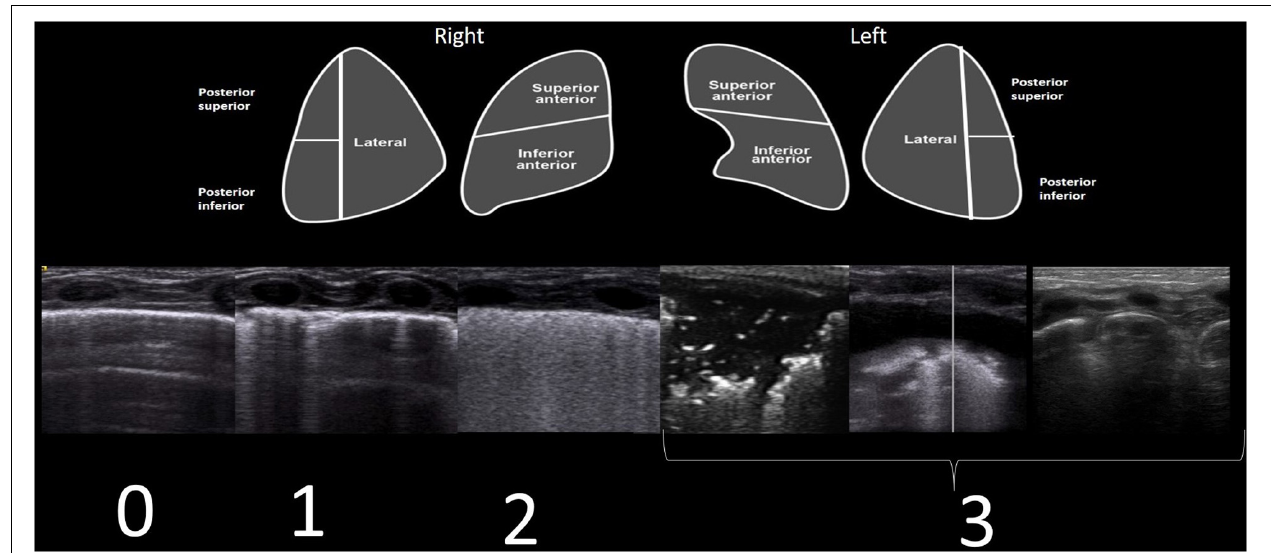
FIGURE 1 | Each lung was divided into five areas (upper part of the figure). For each area, a score of 0–3 was established. LUSS corresponds to four different patterns (lower part of the figure). Scores were given as follows: 0 (defined by the presence of A-lines and pleural sliding); 1 (defined as the presence of three or more well-spaced B-lines); 2 (defined as the presence of coalescent B-lines or white lung); and 3 (defined as the presence of extended consolidations and pleural effusion or absence of lung in the case of lung